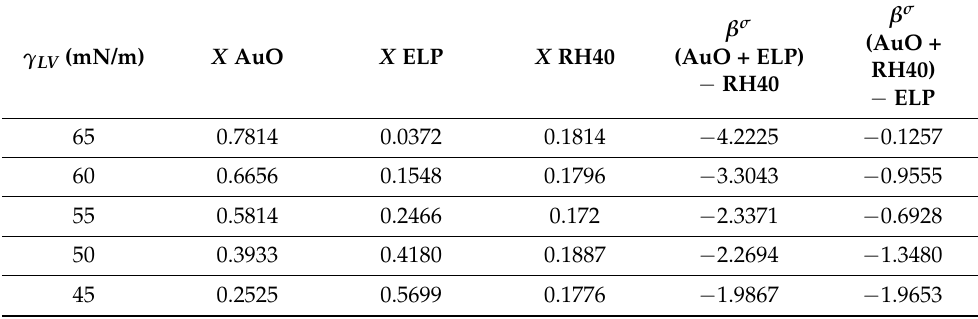
Table 2. The values of the mole fraction of the AuO, ELP and RH40 in the mixed monolayer at the water–air interface ( X as well as the parameter of the intermolecular interactions ( β σ ) for AuO + ELP + RH40 mixture at the different values of surface tension, γ LV